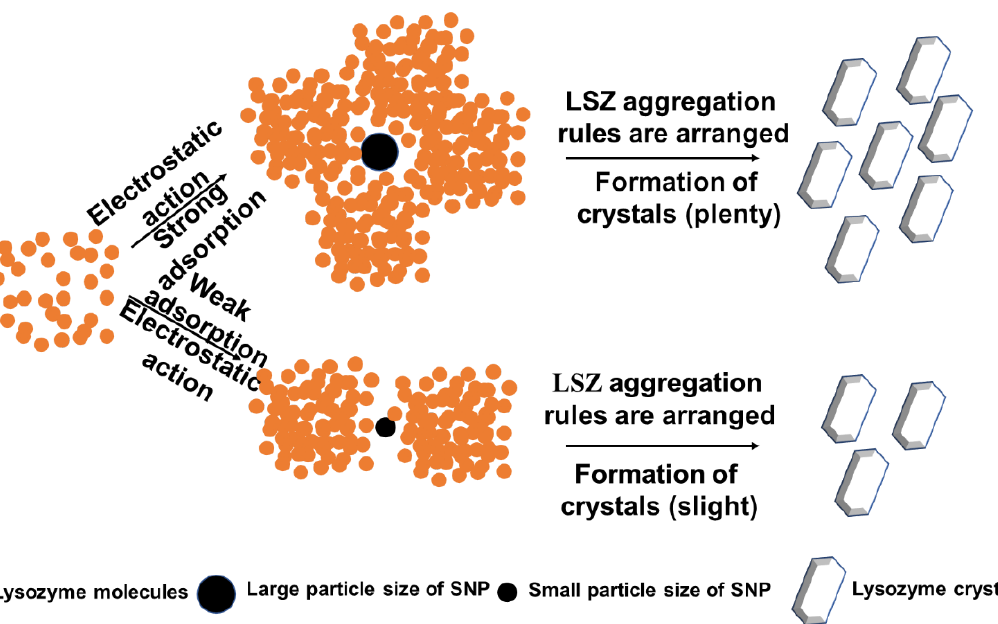
Figure 8. Mechanism of interaction between SNP with different particle sizes and lysozyme. (Note: the figure only shows the mechanism of a single SNP and lysozyme. There are multiple SNP and lysozymes in the specific crystallization process.).